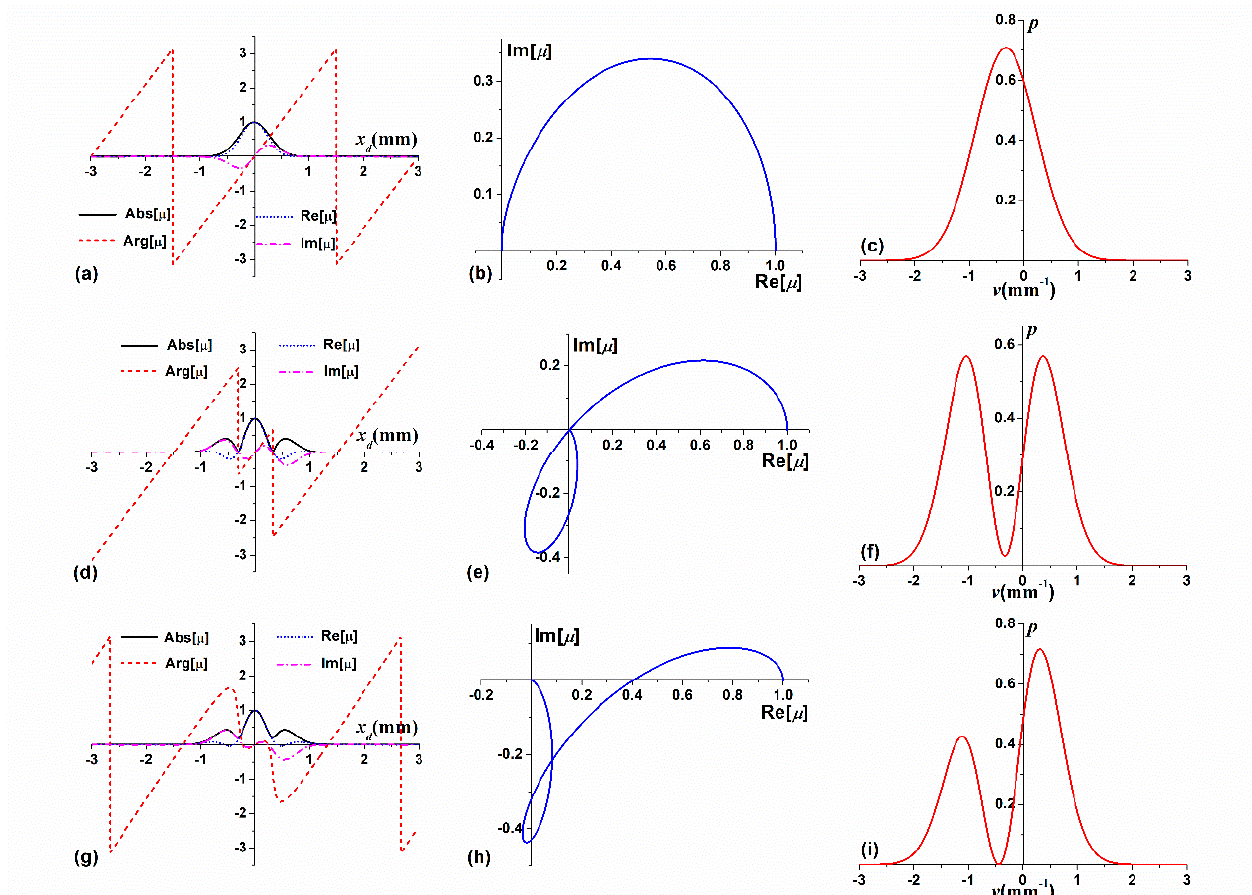
Figure 1. The source coherence states were calculated from Equation (13) and far-field spectral densities calculated from Equation (14) for different values of the source parameters: ( a – c ) δ 1 = δ 2 = 0.2mm, m 1 = m 2 = 2 π /3; ( d – f ) δ 1 = 0.2mm, δ 2 = 0.25mm, m 1 = m 2 = 2 π /3; ( g – i ) δ 1 = 0.2mm, δ 2 = 0.25mm, m 1 = 2 π /3, m 2 = 3 π